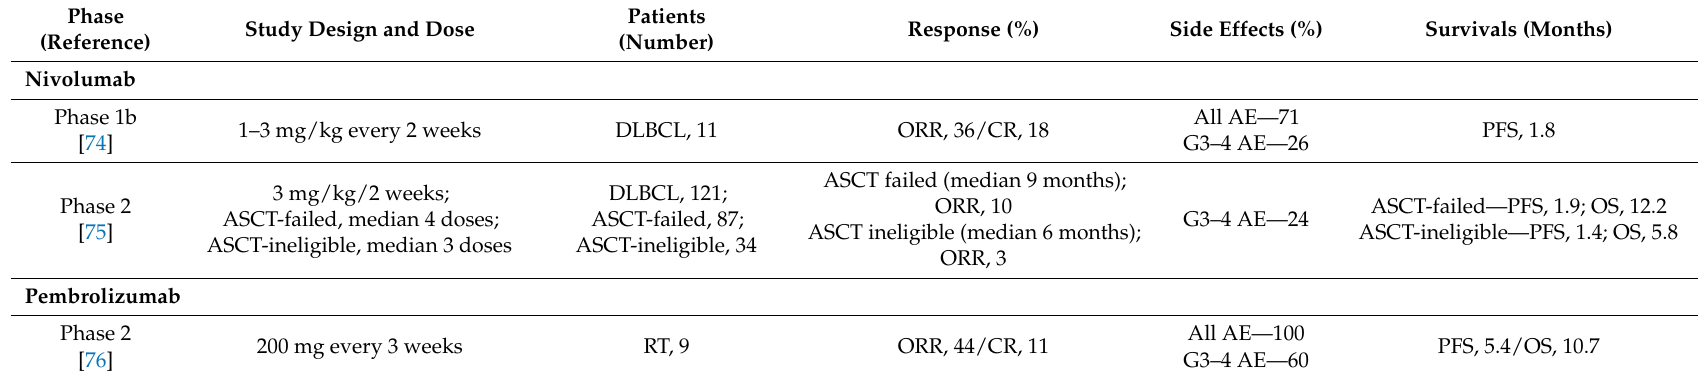
Table 2. Clinical data of PD-1 blockade in diffuse large B cell